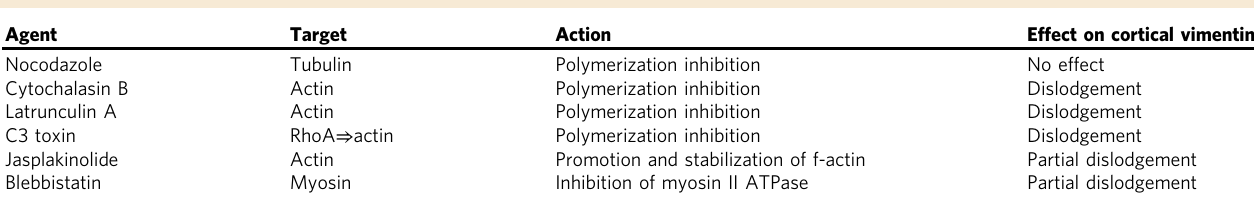
Table 1 Agents used to disrupt cytoskeletal